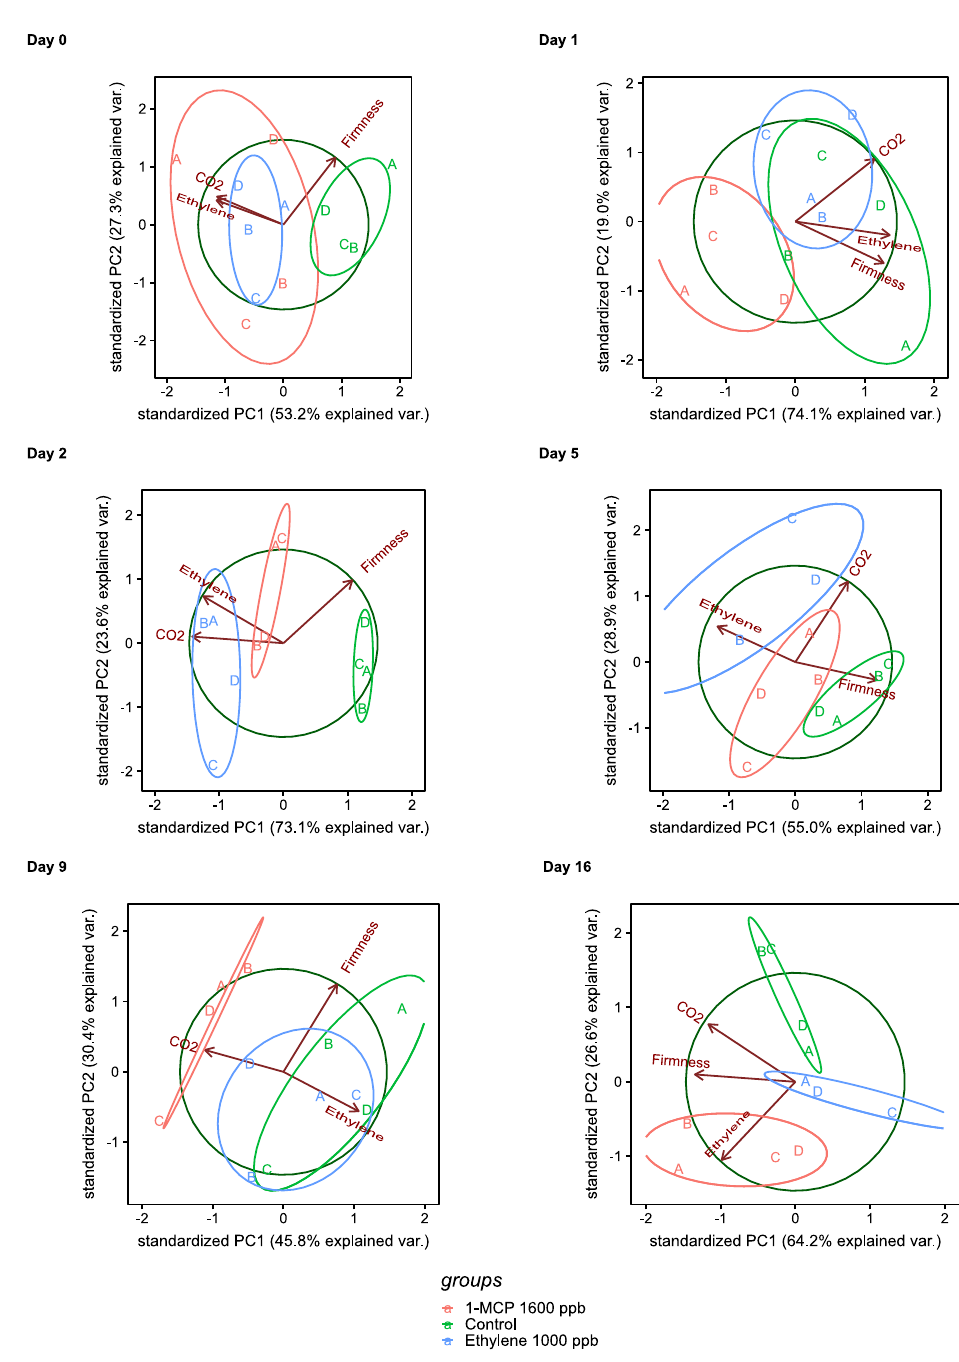
Figure 10. PCA biplot for ethylene, CO 2 and firmness indices of raspberry ( Rubus idaeus ‘Heritage’) fruit during treatment with ethylene and 1-methyl cyclopropane (1-MCP) at 0 °C. The storage assay was performed at the W stage of the raspberry fruit and stored for 16 days and at 0 °C. The PCA analysis was carried out on each sampling day.